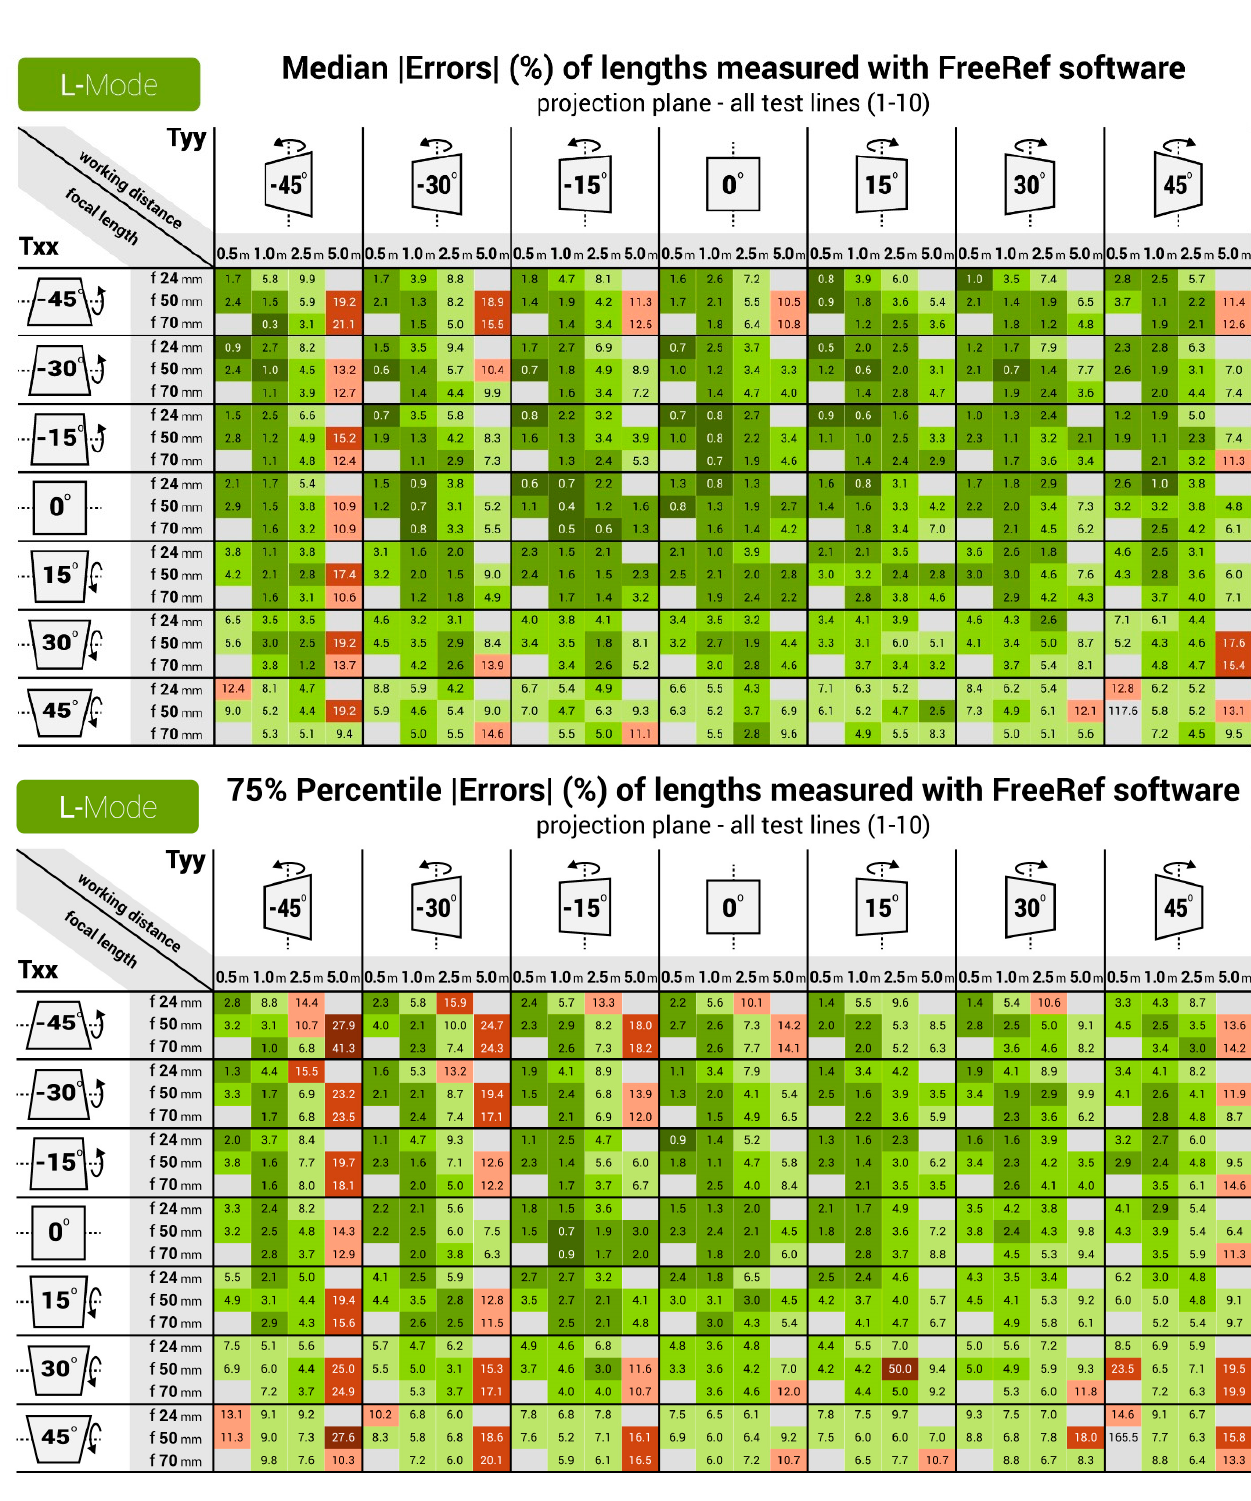
Figure 11. Heat maps for the L-mode verification measurements, showing the ( Top ) median and ( Bottom ) 75 percentile values of absolute percentage measurement errors for all tested focal lengths, working distances and calibration plate rotations Txx and Tyy.